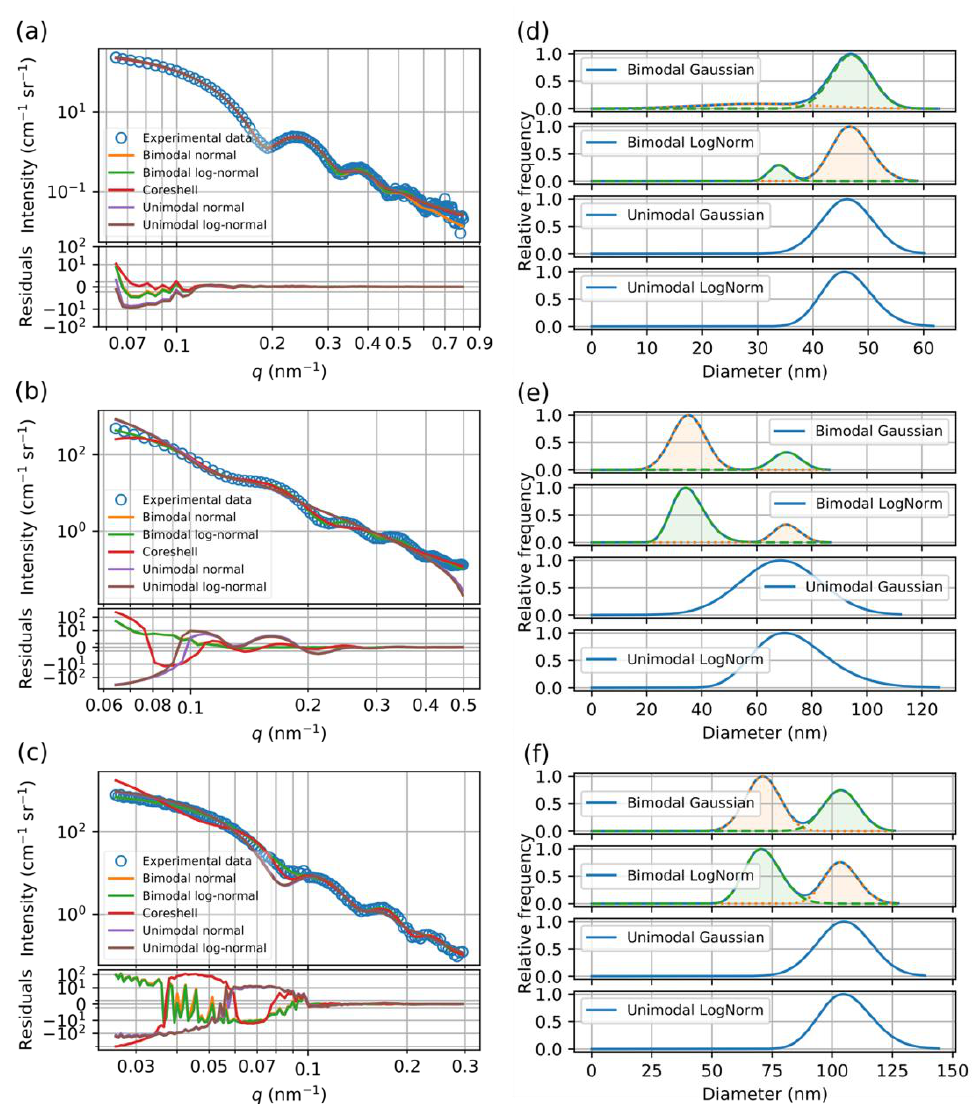
Figure 2. SAXS curves of ( a ) M015, ( b ) M0171 and ( c ) SNP022 samples. The experimental data (open circles) are plotted together with the fitting curves (lines) of various models. The graphs on the right show the fitted size distribution of various models for samples ( d ) M015, ( e ) M0171 and ( f ) SNPs22. Even just looking at the SAXS curves in Figure 2 reveals that the decaying, oscillatory part of the scattering curve is governed by at least two modulations, as the first minimum is broader and shallower than the subsequent ones, indicating that more than one size fractions are required to appropriately describe the sample. The numerical results in Table 2 corroborate that bimodal models fit the measured curves much better than unimodal ones in terms of the reduced χ 2 goodness of fit parameter. Additionally, log ‐ normal size distributions fit better than normal distributions, probably because they better describe the underlying growth process. Another, general feature observed in Table 2 is that, because the scattering power of an object is proportional to the 6th power of its linear size, the larger size fraction dominates the scattering curve, making the determination of the smaller size fraction more uncertain. Finally, as the core ‐ shell model was not able to provide satisfactory fit to the scattering curves, this alternative model can be ruled out. The best fitting bimodal PSDs with log ‐ normal size distributions obtained by SAXS are also shown in Figure 1b,d,f. It can be concluded from the comparison to the PSDs determined by other